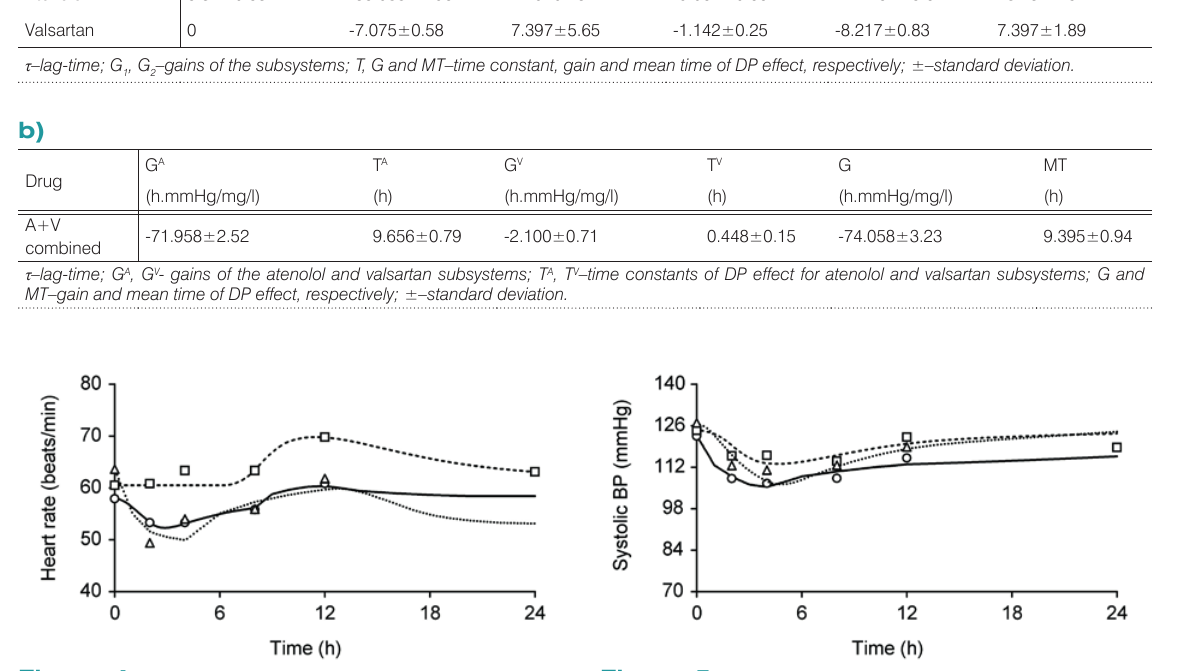
Figure 4. The PK/PD model solution of HR time profile related to measured atenolol (triangles), valsartan (squares) concentrations and their combination (circles).